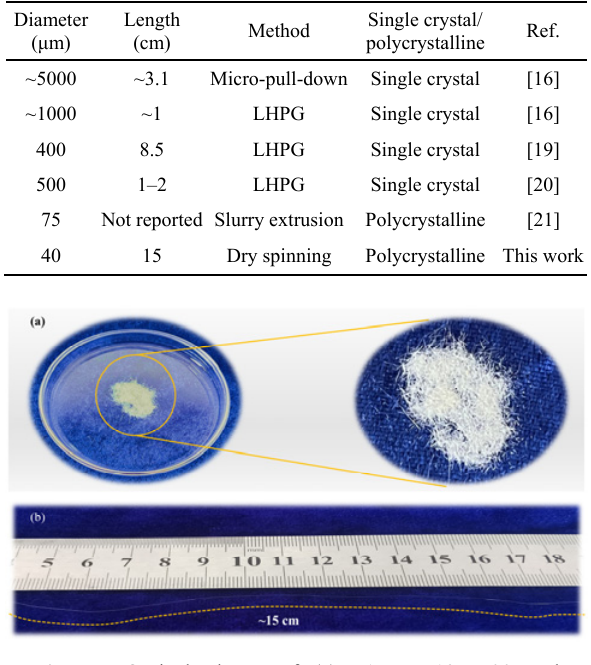
Fig. 7 Optical photos of (a) PAWVT-135–700 and (b)